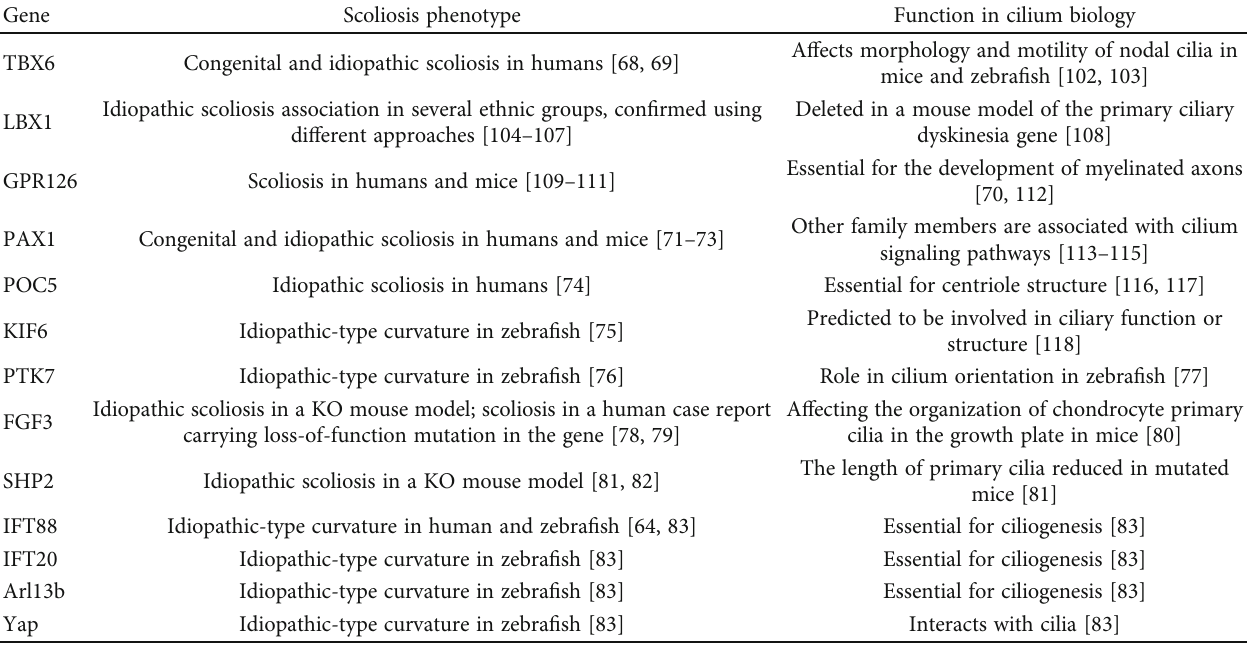
Table 3: Primary cilium-related gene and